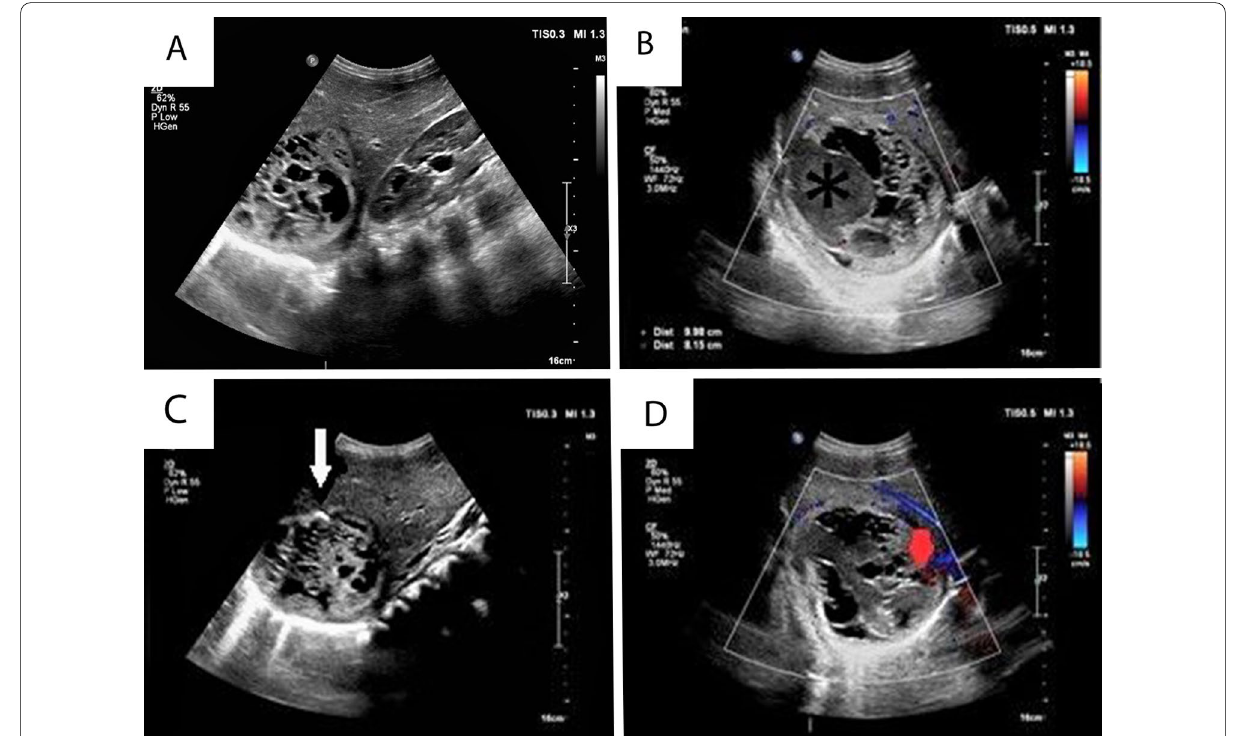
Fig. 1 The abdominal US showed a well-defined right hepatic multilocular cystic mass ( A ) with turbid locules (black star) ( B ), Peripheral coarse calcification (white arrow) ( C ), and scanty septal vascularity by Doppler (red arrow) ( D